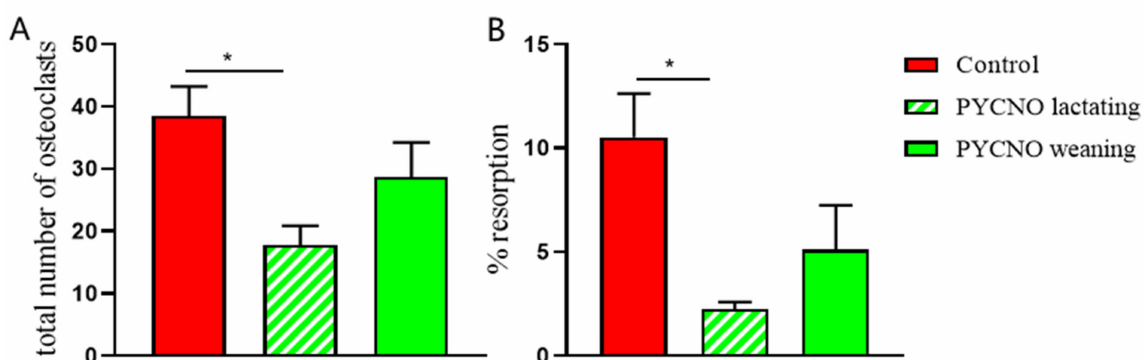
Figure 2. The total number of osteoclasts and resorption. ( A ) The number of osteoclasts was counted after 4 weeks of culture and the total number of osteoclasts was assessed. During the lactation period a lower number of osteoclasts was found in the PYCNO group compared to the control. * p < 0.05. ( B ) The from CD14 + cells generated osteoclasts were cultured on trabecular bone slices and resorption area was measured. The area resorbed by the PYCNO is significantly smaller compared to the control. * p < 0.05.